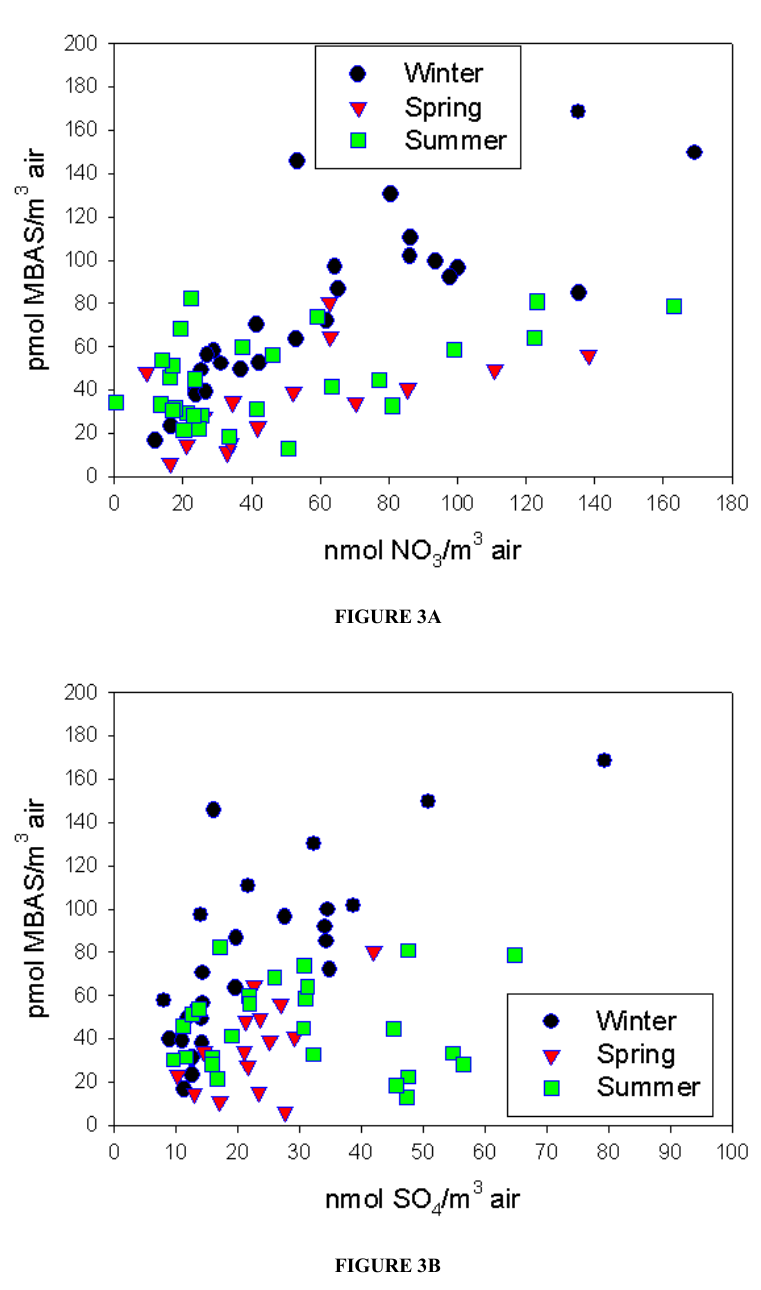
FIGURE 3. (A) MBAS concentration in the atmosphere as a function of aerosol nitrate content. (B) The MBAS concentration in the atmosphere as a function of aerosol sulfate content. = 0.89, n = 27, p < 0.001 with Once again the relationship is clearer for the winter samples (r s = 0.79, n = 27, p < 0.001 with sulfate) partly because of the broader concentration nitrate, and r s ranges. A reasonable correlation (r = 0.67, n = 66, p < 0.001) is also found between the MBAS s concentration (Fig. 4). The values here were taken from the automated concentration and NO x rural site at Wicken Fen, some 80 km to the west[27]. There was also a relationship with NO x within the nearby city of Norwich (r = 0.71, n = 70, p < 0.001), but it is likely that the rural s